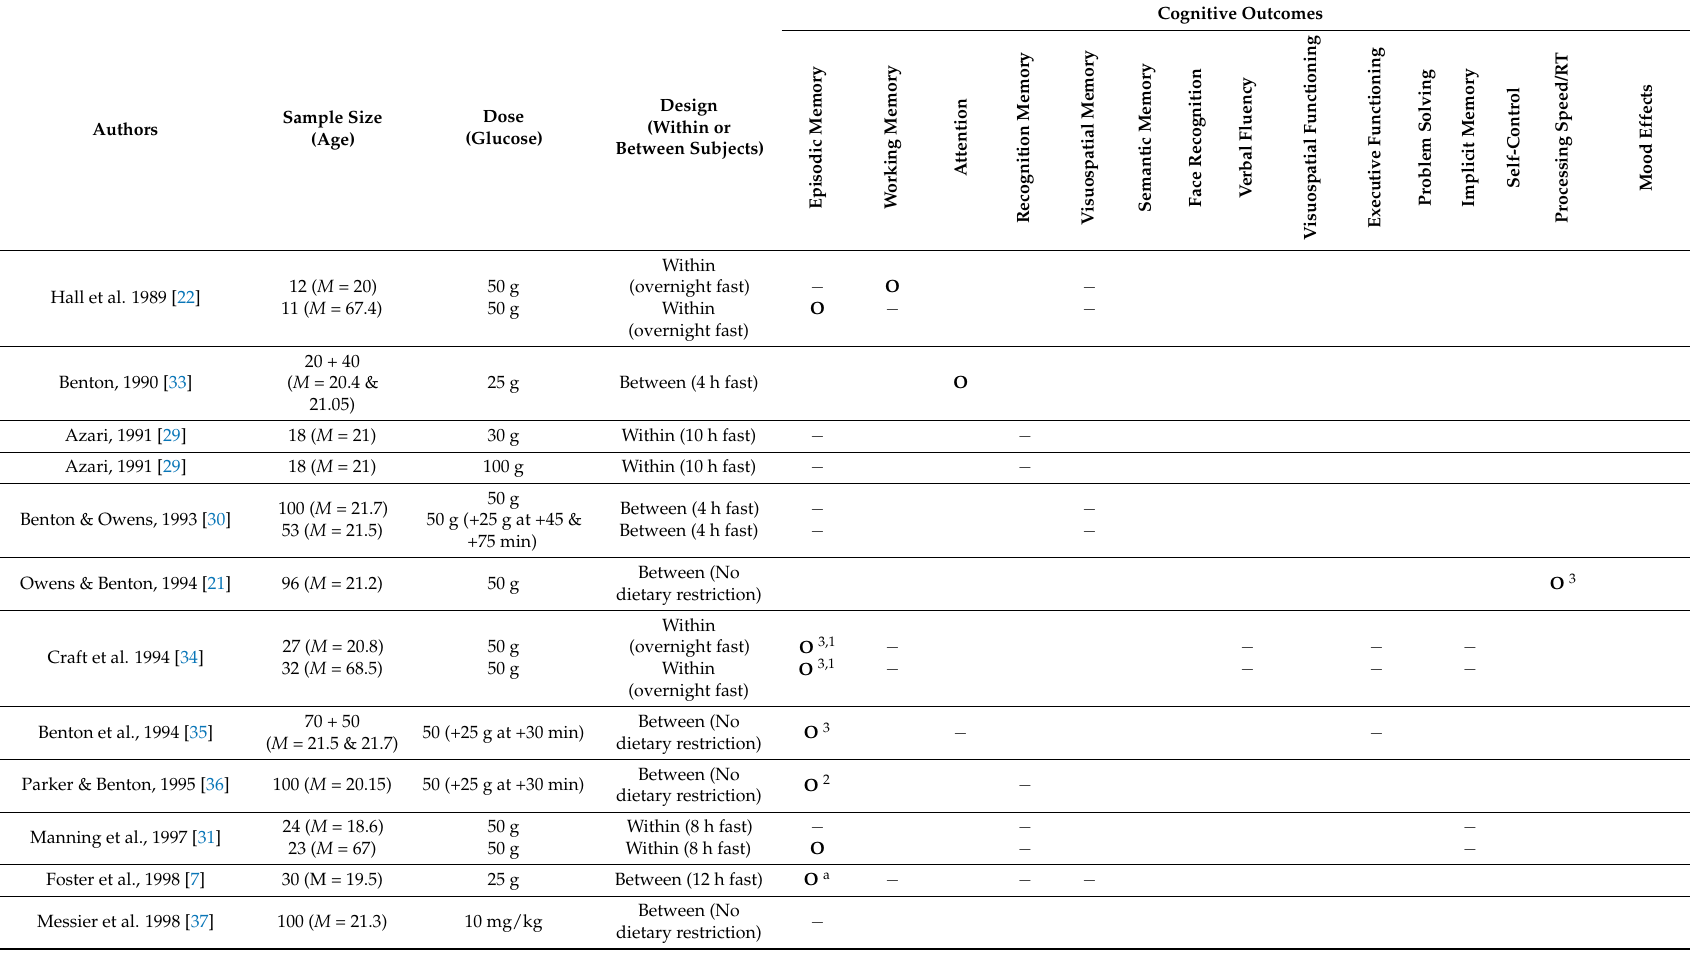
Table 2. Summary of studies examining the effects of glucose on cognitive performance domains and